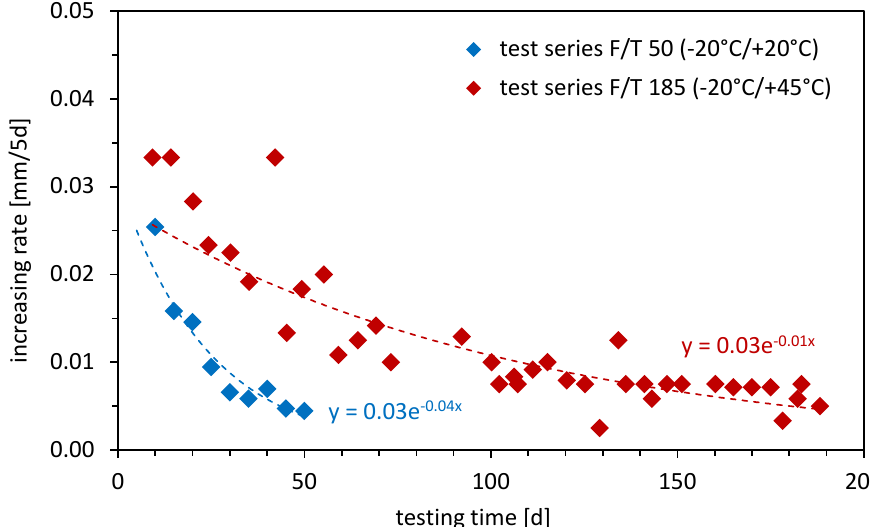
Figure 9. Development of increasing rate of the measured displacements per 5 days in the freeze-thaw tests for different testing protocols.